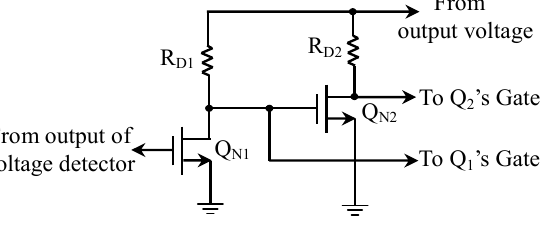
Figure 3. A control logic circuit consisting of two NMOS transistors.